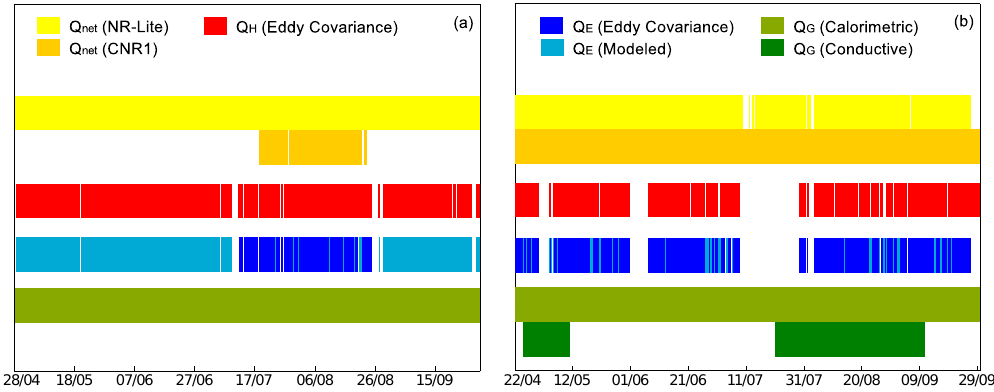
Fig. 2. Availability of net radiation Q net , sensible heat flux Q H , latent heat flux Q E , , and ground heat flux Q G during the observation periods in (a) 2007 and (b) 2008. Values obtained by different sensors and approaches are indicated